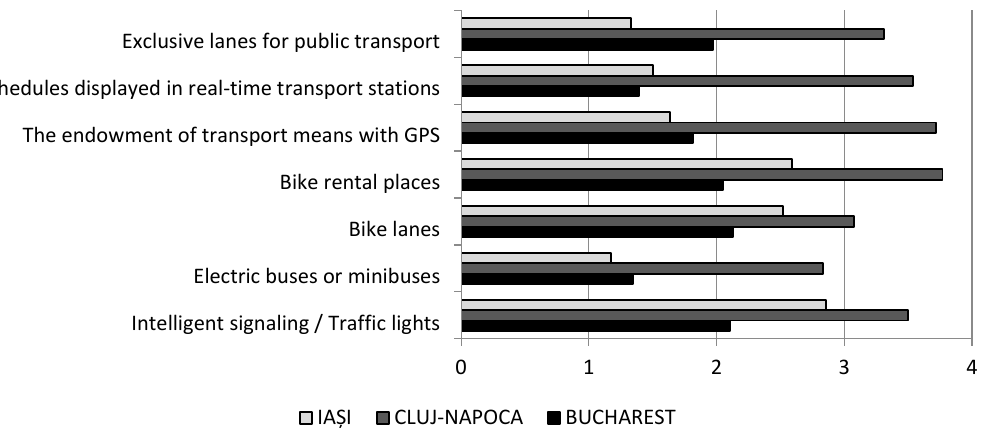
Figure 6 : The degree of implementing certain innovations in public transport in three important Romanian cities – average scores (0 = not implemented, 5 = fully